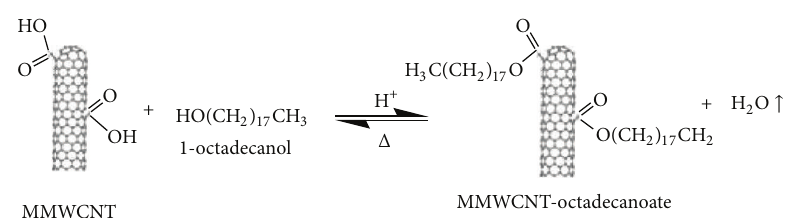
Figure 2: Chemical esterification of modified carbon nanotubes (M-CNTs) [44].